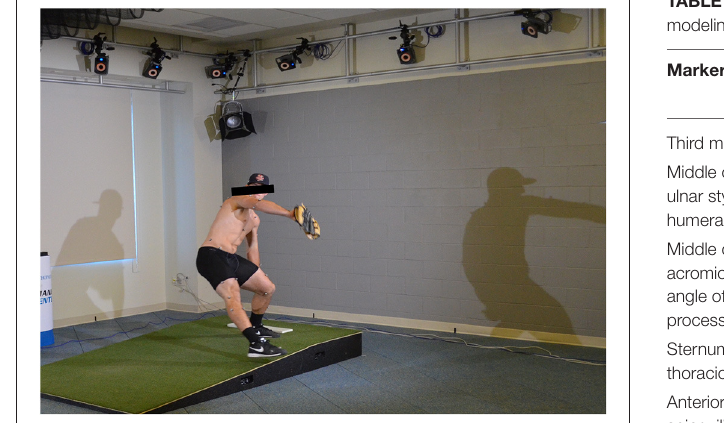
FIGURE 1 | Illustration of collegiate baseball pitcher undergoing 3D motion capture.